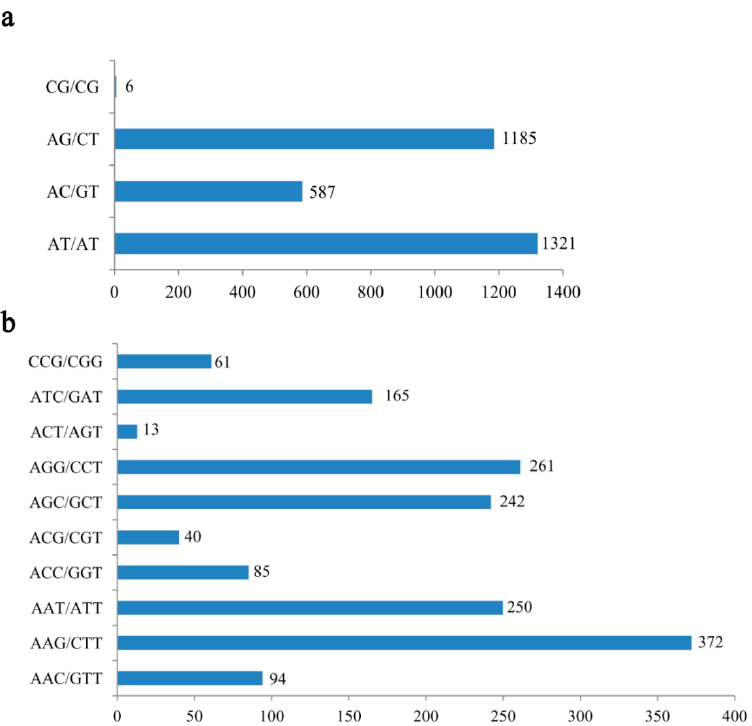
Figure 2. Number of various ( a ) di- and ( b ) trinucleotide repeat motifs in Amentotaxus formosana .